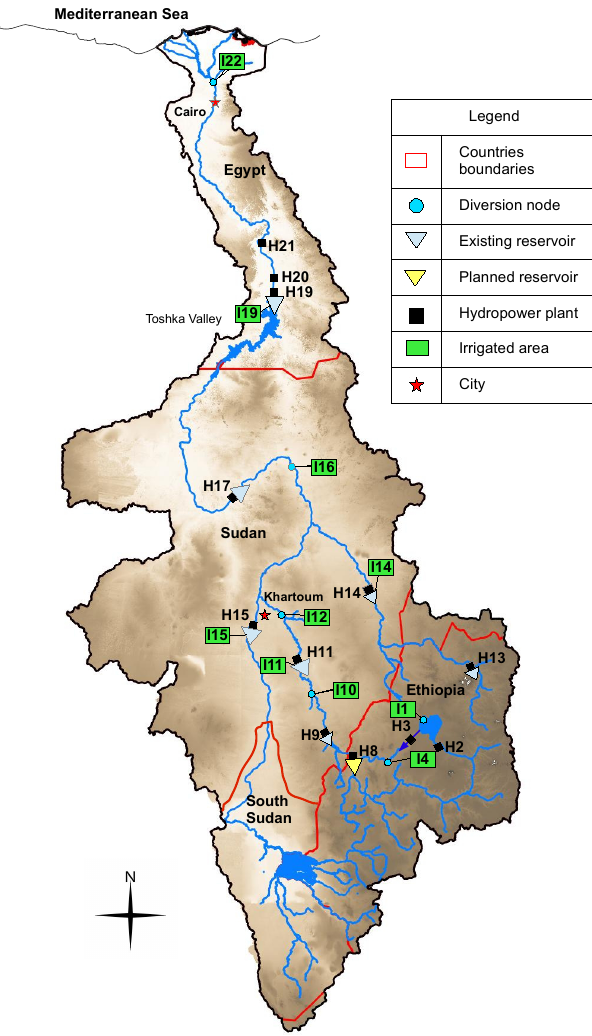
Figure 6. Model schematic of the Eastern Nile River basin. Irriga- tion agents (I) and hydropower agents (H) for this case study are shown. Note that the numbering is not consecutive because there are nodes that represent agents that are not part of the case